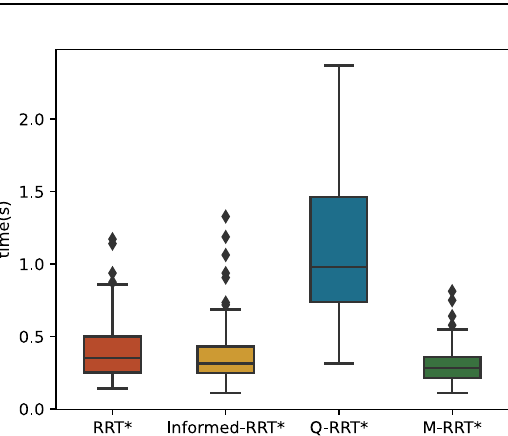
Sensors 2022 , 22 , x FOR PEER REVIEW Figure 13. t init in the cluttered environment. Figure 13. t init in the cluttered environment.